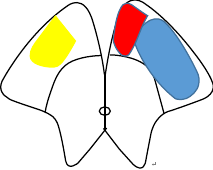
Figure 2: Schematic diagram of the involved areas of cerebral peduncular infarction showing the present case on the right side (yellow), the case from Dehaene and Dom’s report (red + blue), and the case from Tarek Zakaria’s report (blue) on the left